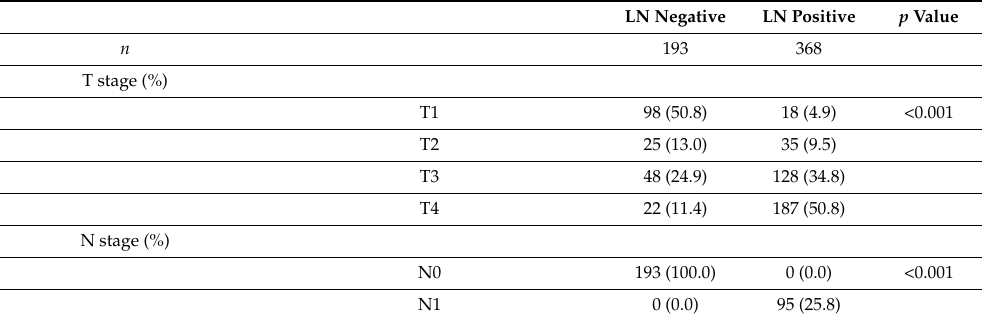
Table 1. Characterization of included patients in this study divided by lymph node (LN) metastatic negative or positive